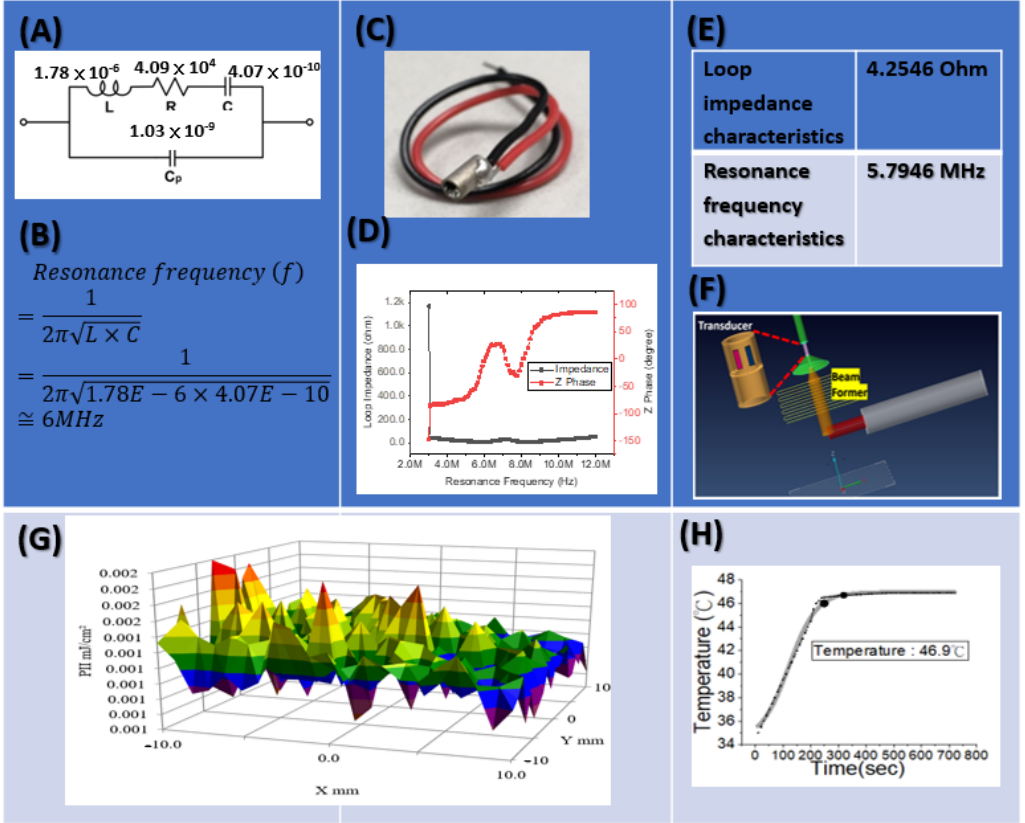
Figure 1. Single-channel cylindrical piezoelectric ultrasonic element (Channel A). ( A ) Measure resonance frequency model, The Butterworth-Van Dyke (BVD) equivalent circuit extracted data of the actual elements and calculated the equivalent resistor, inductor, and capacitor (RLC) elements. The advantage of the BVD equivalent circuit is that the circuit can be analyzed quickly. ( B ) Parameters, Cp: capacitance between the two electrode plates of the piezoelectric element, R: impedance is equal to R at resonance, C: capacitance is equal to C at resonance, L: inductance is equal to L at resonance. ( C ) Cylindrical piezoelectric ultrasonic element, ( D ) Loop impedance of Channel A, ( E ) Resonance condition, ( F ) Beam former scanning, ( G ) Energy profile, ( H ) Temperature observed.